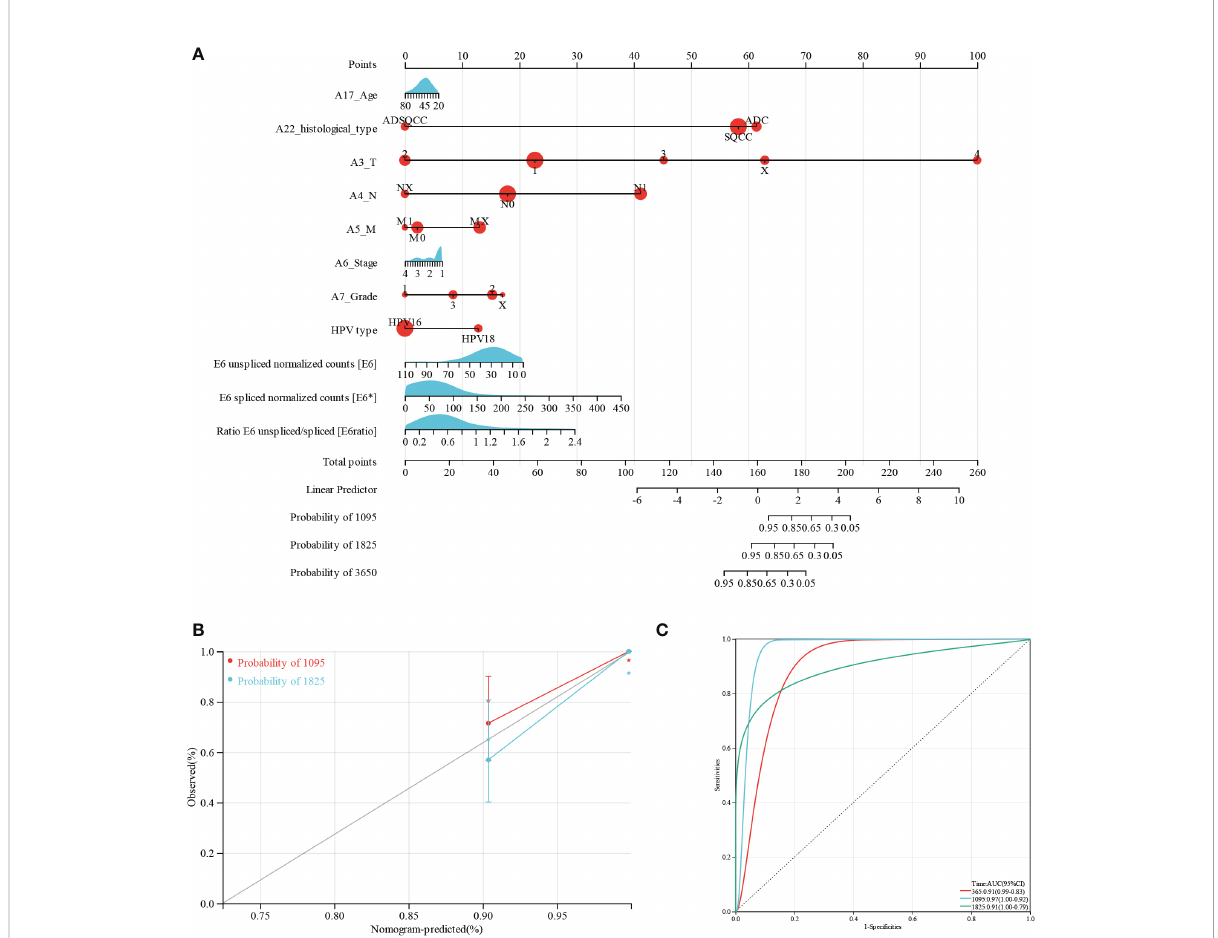
FIGURE 1 Predictive nomogram construction and validation. (A) A nomogram for predicting the 3-, 5-, and 10-year OS of patients with CESC. (B) Nomogram calibration curves for OS prediction at 3 and 5 years. (C) ROC analysis of